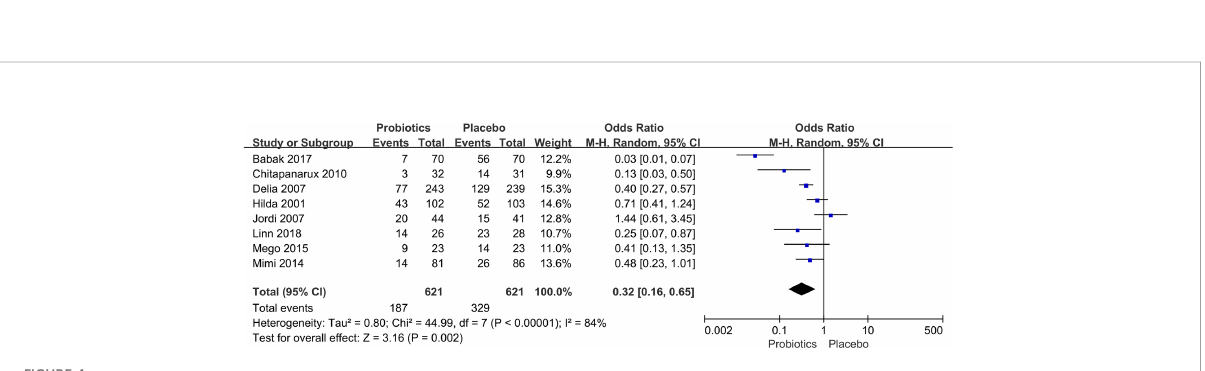
FIGURE 4 Forest plot of incidence of diarrhea in probiotic and placebo groups after radiation or chemotherapy for pelvic and abdominal